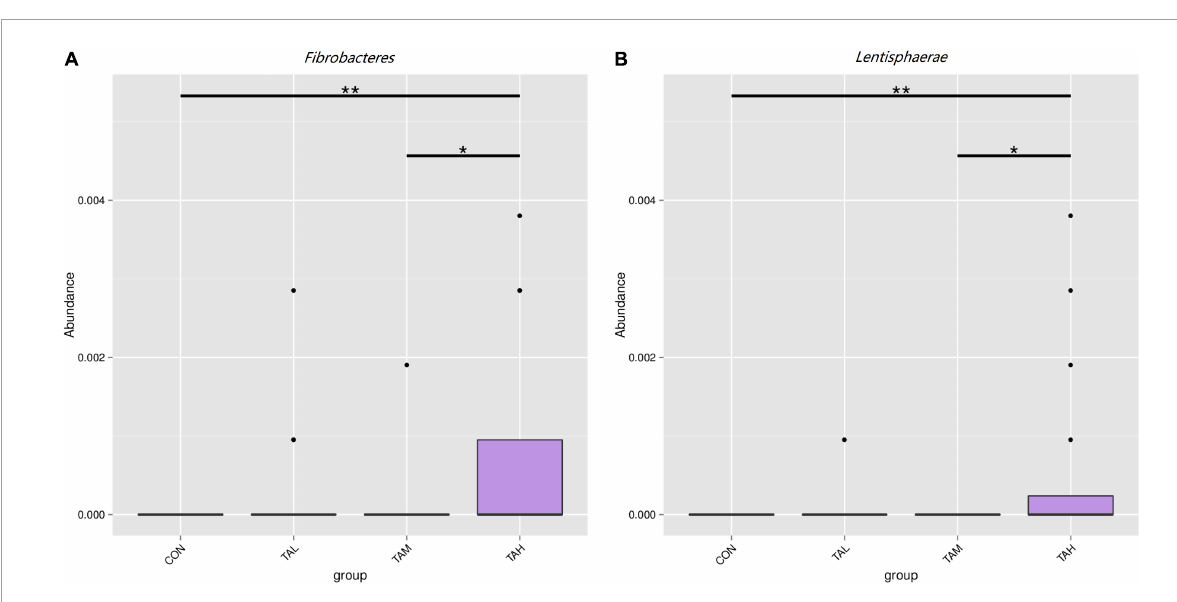
FIGURE2 Differential bacterial phyla in the rumen fluid across the four treatments. (A) Fibrobacteres . (B) Lentisphaerae . *Means that the difference between two treatments was significant ( P < 0 . 05). **Means that the difference between two treatments was highly significant ( P < 0 .